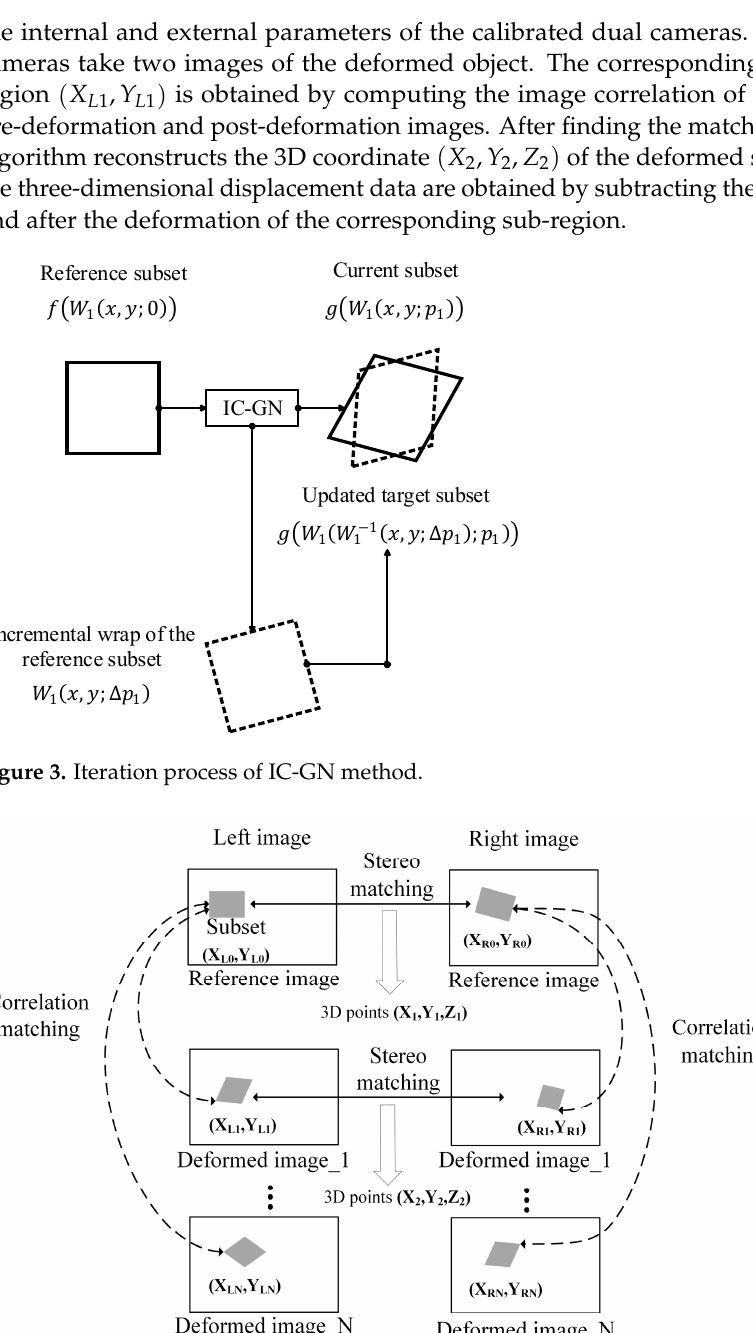
Figure 4. 3D-DIC measurement principle.